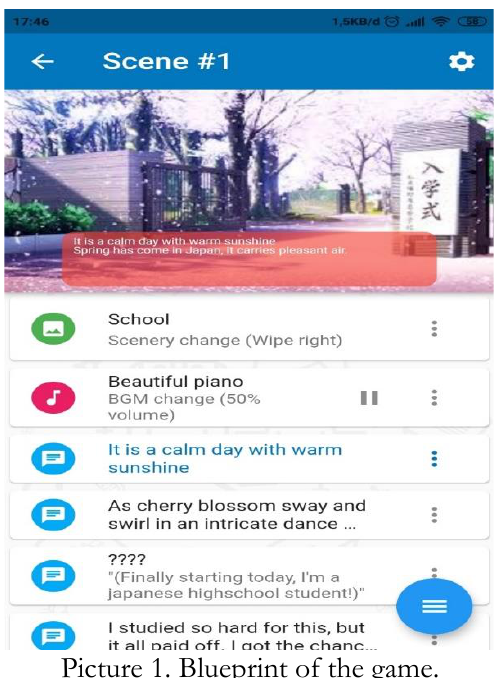
Picture 1. Blueprint of the